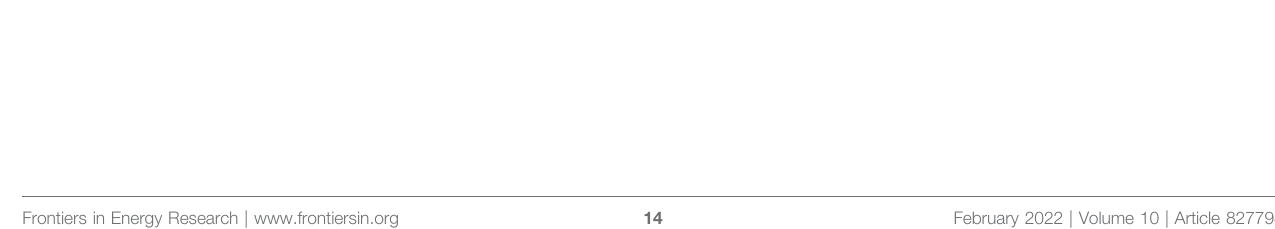
Frontiers in Energy Research |